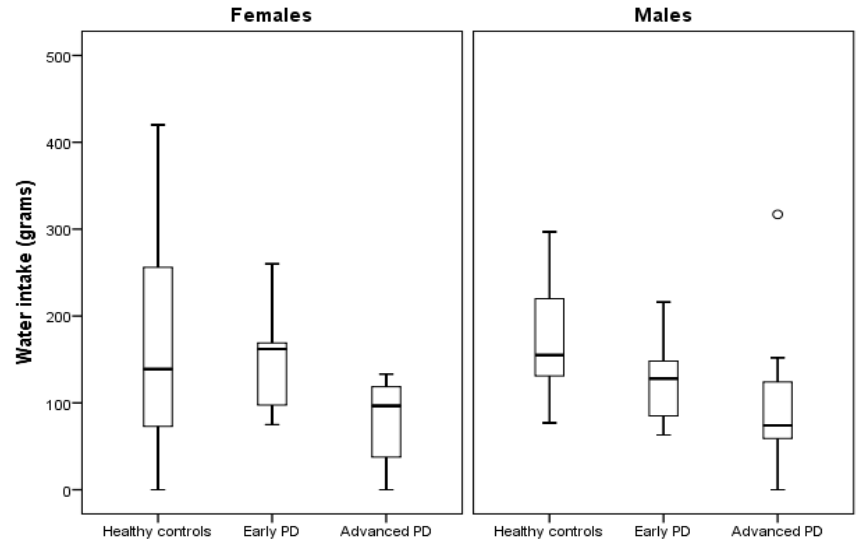
Figure 4. Boxplot illustrating group differences in water intake (grams) after sex stratification. Parkinson’s disease (PD). The circle represents a participant with a water intake value > 1.5 × interquartile range.